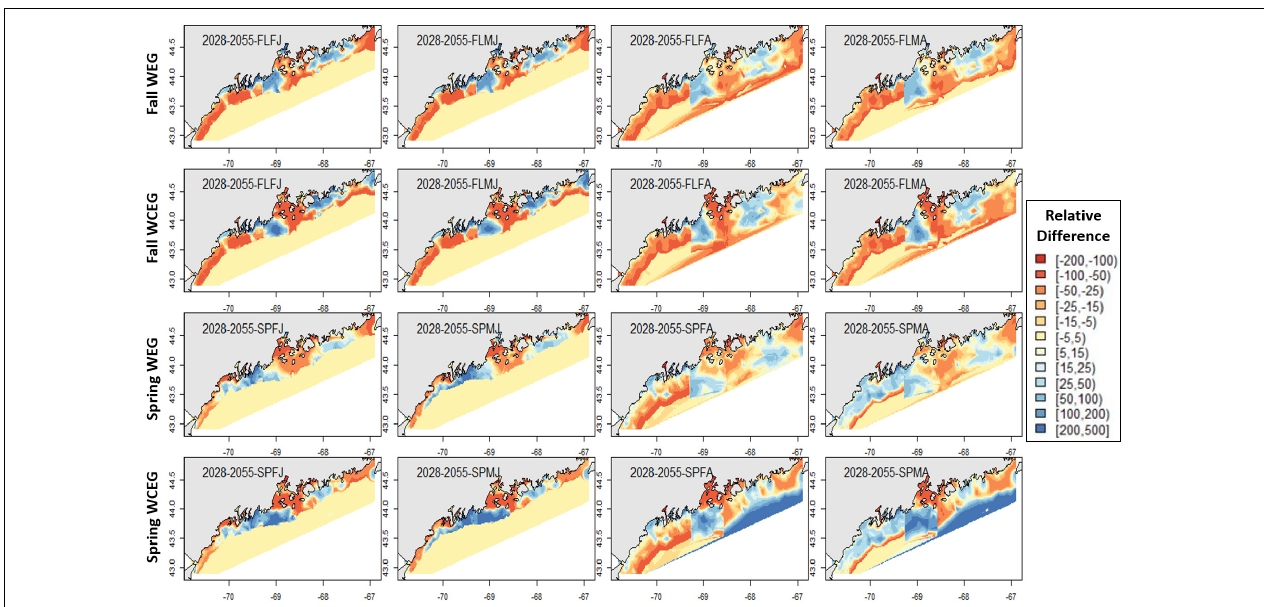
FIGURE 10 | Forecasted American lobster relative differences in model abundance estimates for the period 2028–2055. Legend numbers represent relative differences (%) between the West-East1-GAM (WEG) approach or the West-Central-East2-GAM (WCEG) approach and the GOM–GAM. Red legend colors indicate areas where the GOM–GAM model is predicting higher lobster abundance than the localized model approach in comparison. Blue legend colors indicate areas where the GOM–GAM model is predicting lower lobster abundance then the localized model approach in comparison. Pale yellow colors indicate similar abundance estimates between the large-scale and localized models. Each column represents a lobster season × sex × size group. Each row represents the season and model type compared to the corresponding